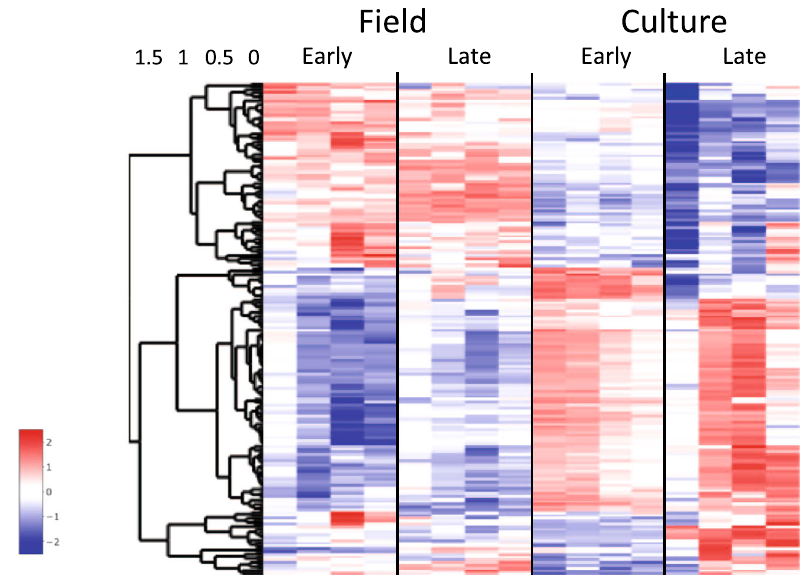
Fig. 6 Expression heatmap showing z-scores of DEGs involved in oogenesis. Differentially expressed genes between fi eld/diapause program and culture/ reproductive program and early and late CV copepodids annotated with the ‘ oogenesis ’ [GO:0048477] GO term and its child terms ( n = 178). Color- coding for each gene indicates the magnitude of expression as z-scores of each individual sample. Relative expression of each sample is given in a separate column (ordered by group) as labeled at the top. Genes (rows) were ordered by hierarchical clustering.